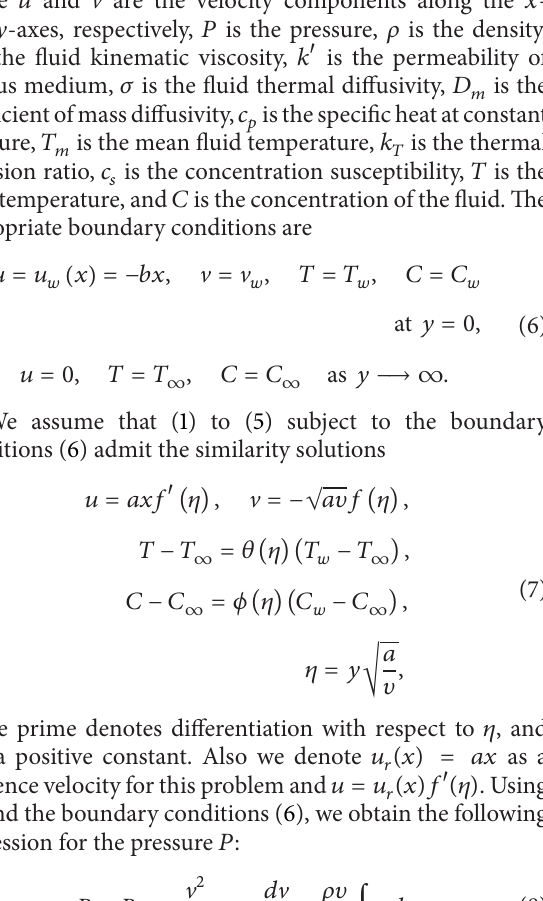
the generated vorticity is not confined within the boundary layer. So, to overcome this difficulty the flow needs a certain amount of external opposite force at the sheet. The most suitable external force is the suction at the sheet. Miklavˇciˇc and Wang [17] investigated the shrinking flow where velocity of boundary layer moves toward a fixed point. They found an exact solution of the Navier-Stokes equations and reported that an adequate suction is necessary to maintain the flow over a shrinking sheet. This phenomenon can be found, for example, on a rising and shrinking balloon